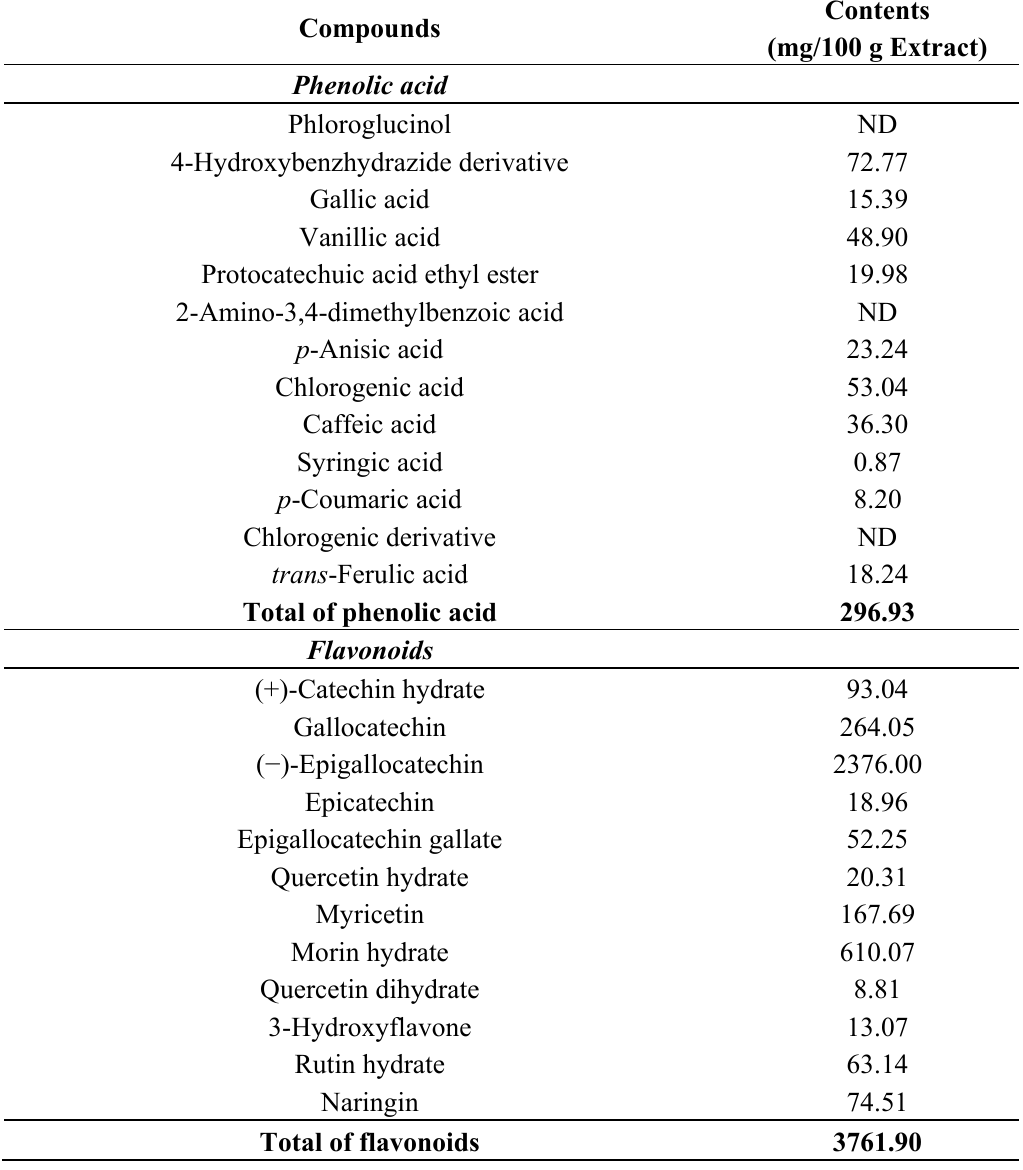
Table 7. The major phytoconstituents composition of aqueous extracts of C. setidens